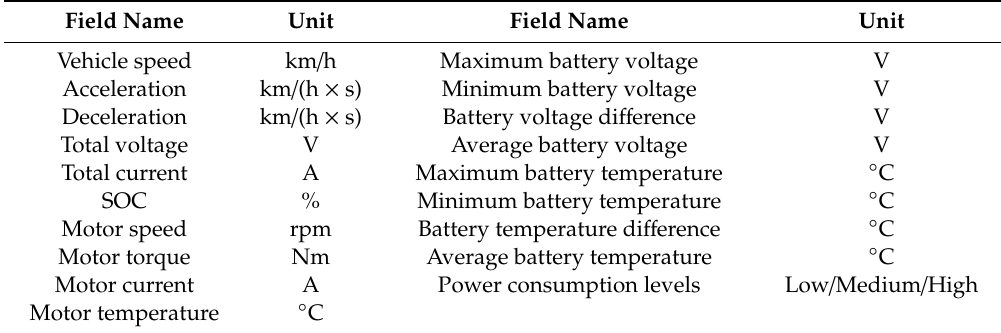
Table 3. Dataset for machine learning.